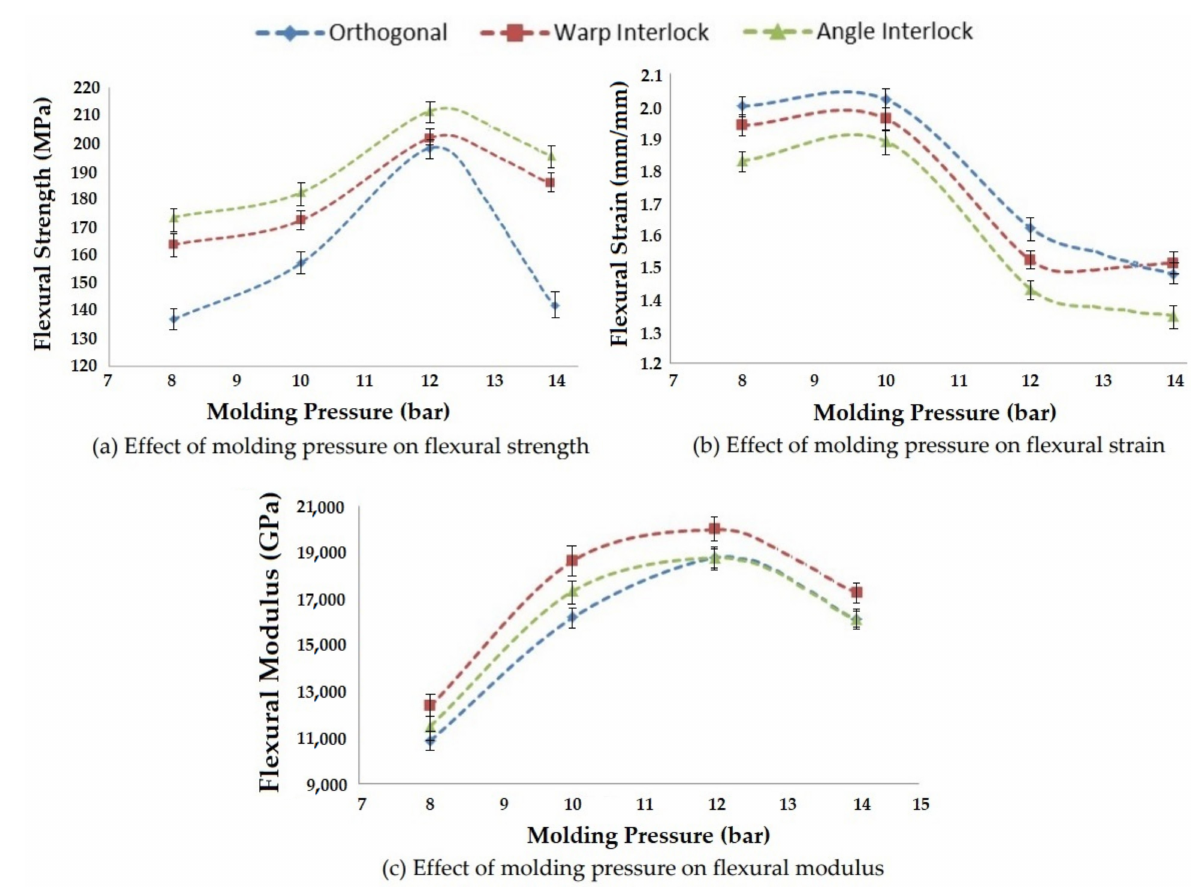
Figure 22. Effect of molding pressure on the flexural properties of 3D woven